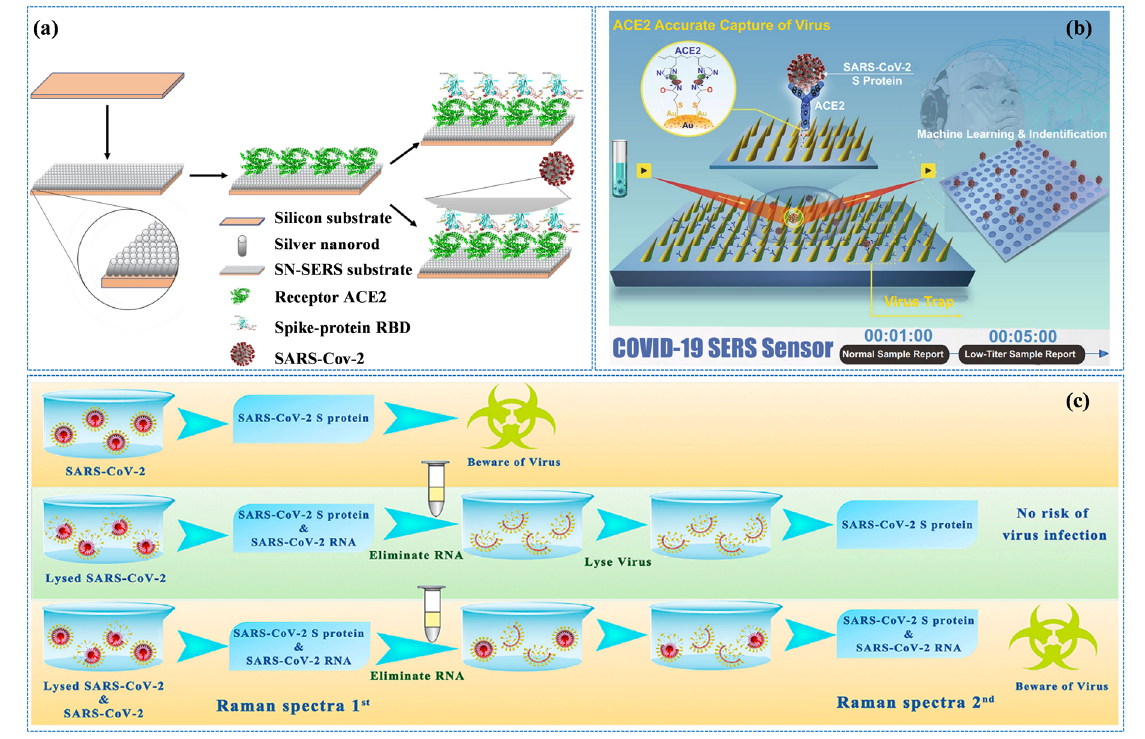
Figure 8. ( a ) State-of-the-art diagram of SERS sensing for interrogating SARS-CoV-2. Reprinted with permission from ref. [88]. Copyright 2021, Elsevier. ( b ) Schematic diagram of the operation procedure of COVID-19 SERS sensors. Reprinted with permission from ref. [89]. ( c ) The schematic of the two-step SERS detection based on SnS 2 microspheres for diagnosing the infectiousness of SARS-CoV-2. Reprinted with permission from ref. [90]. Copyright 2022,